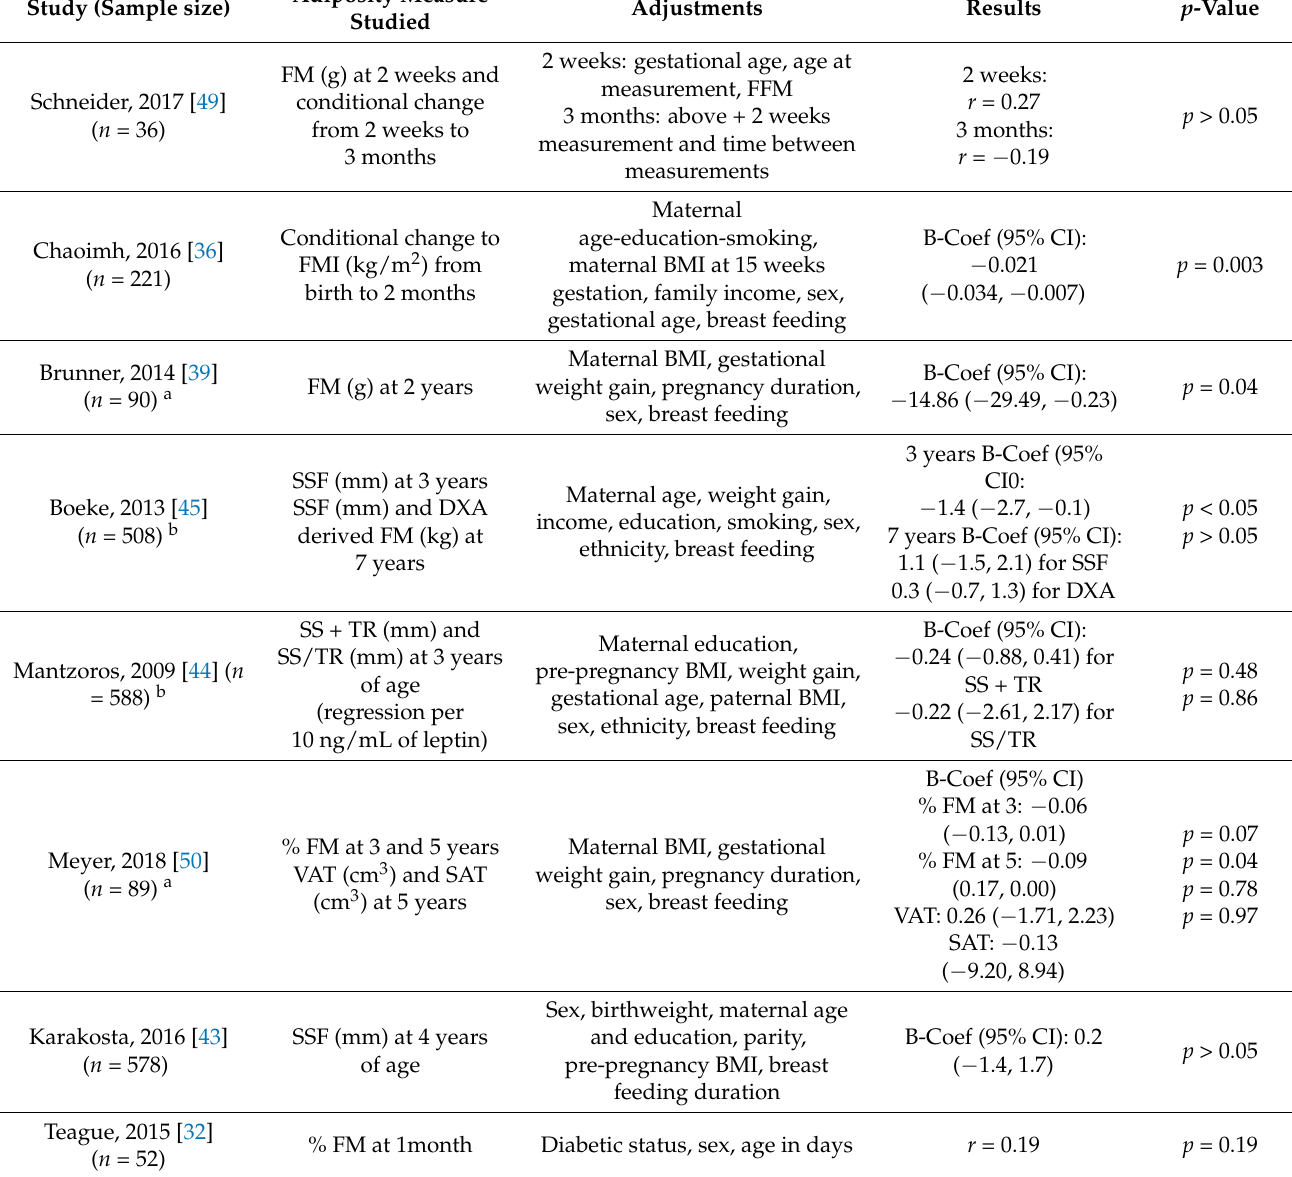
Table 2. Cord blood leptin and adiposity in early